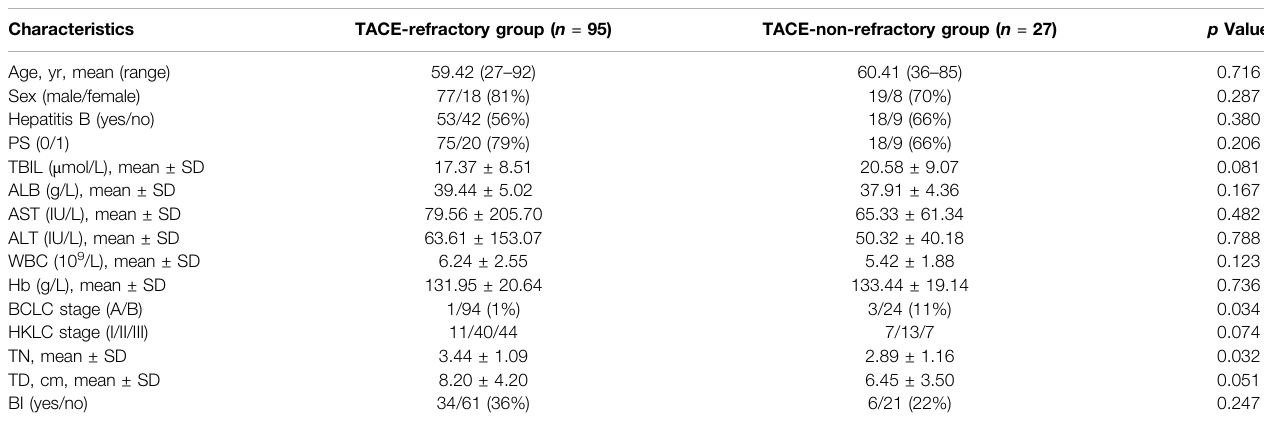
TABLE 2 | Baseline characteristics in the validation cohort.